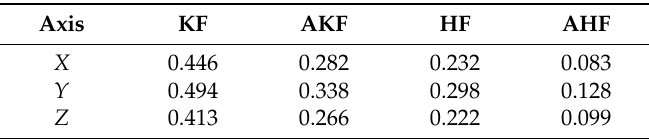
Table 3. RMSE values of the schemes